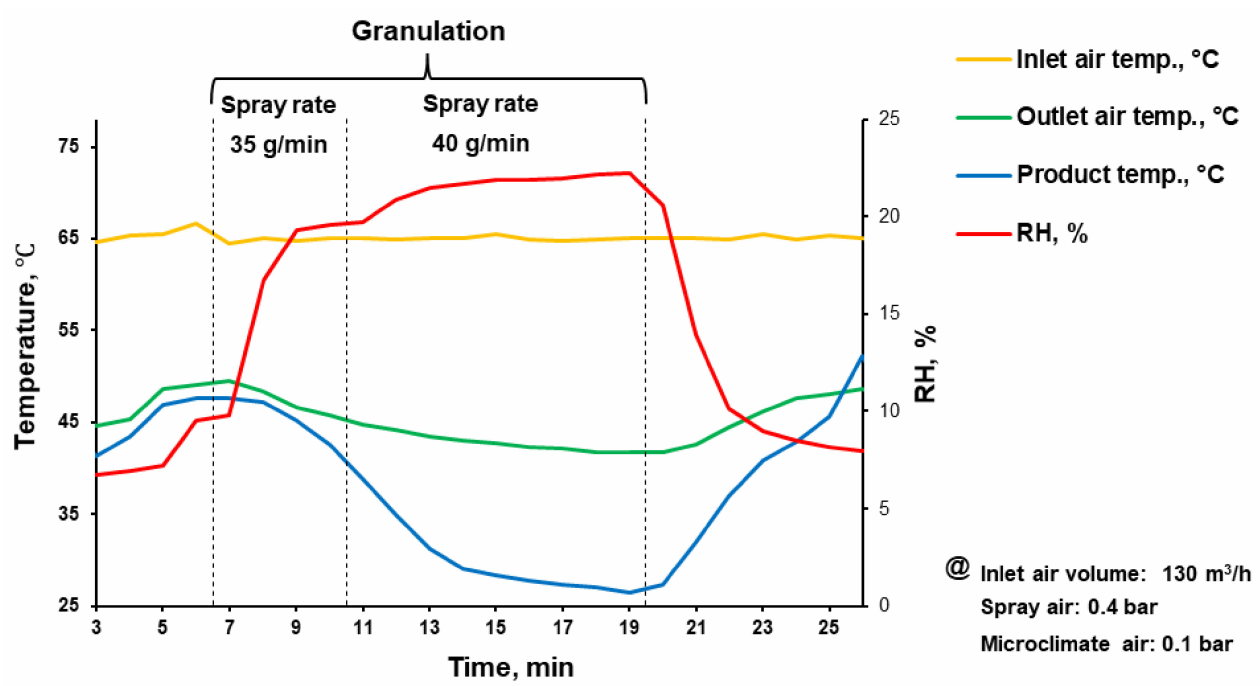
Figure 1. Actual parameters of fluid-bed wet granulation